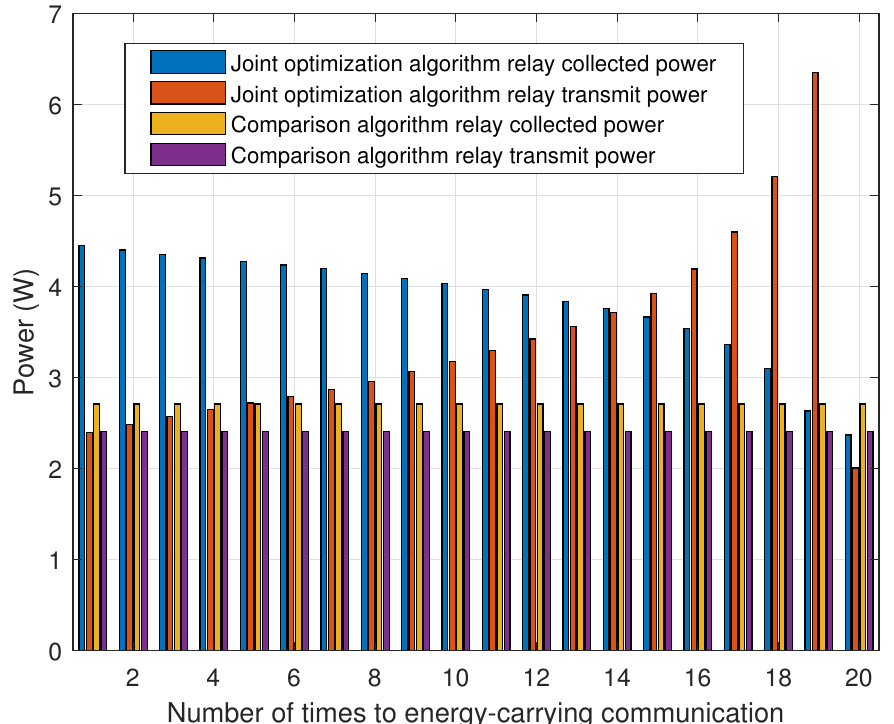
Figure 5. Comparison of relay collected energy and transmitted power in the joint optimization algorithm and comparison